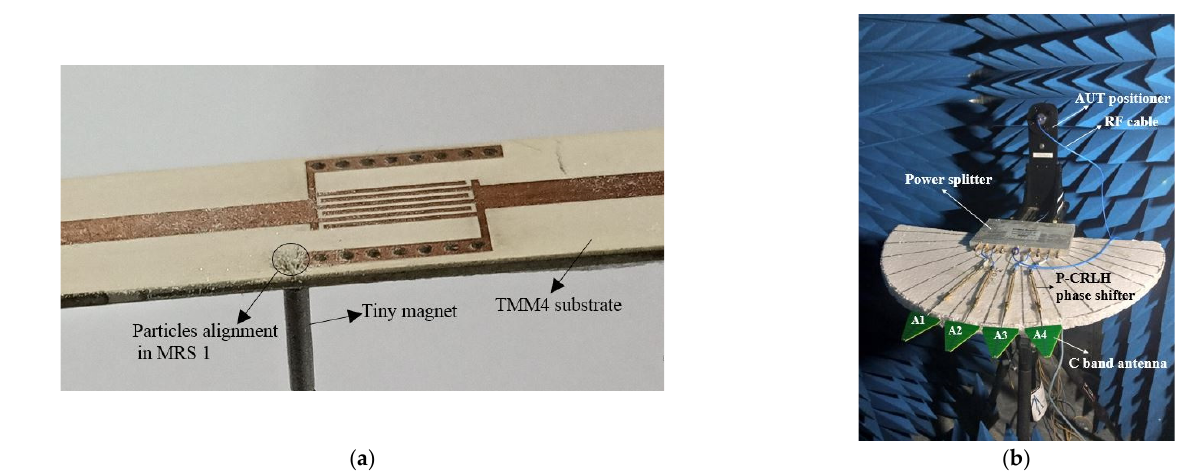
Figure 7. Photographs of ( a ) A fabricated unit cell P-CRLH phase shifter; ( b ) A P-CRLH phase shifter-based 1 × 4 cylindrical antenna array in an anechoic chamber.